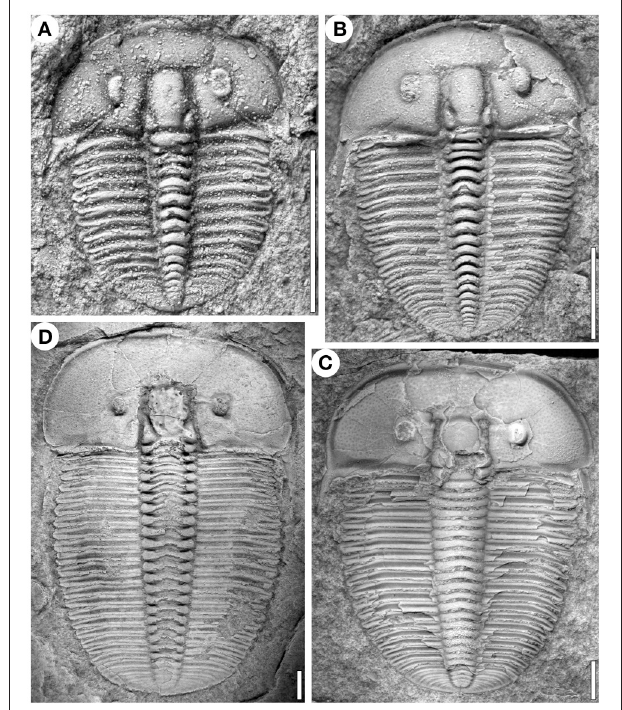
FIGURE 1 | Specimens of Aulacopleura koninckii at different developmental stages (see text). (A) s 12 . (B) s 17 . (C) ca. s 27 . (D) ca. s 30 . (A,B and D) from Na ˇ Cernidlech, Czech Republic, and (C) from Arethusina Gorge, Czech Republic. Scale bars 2